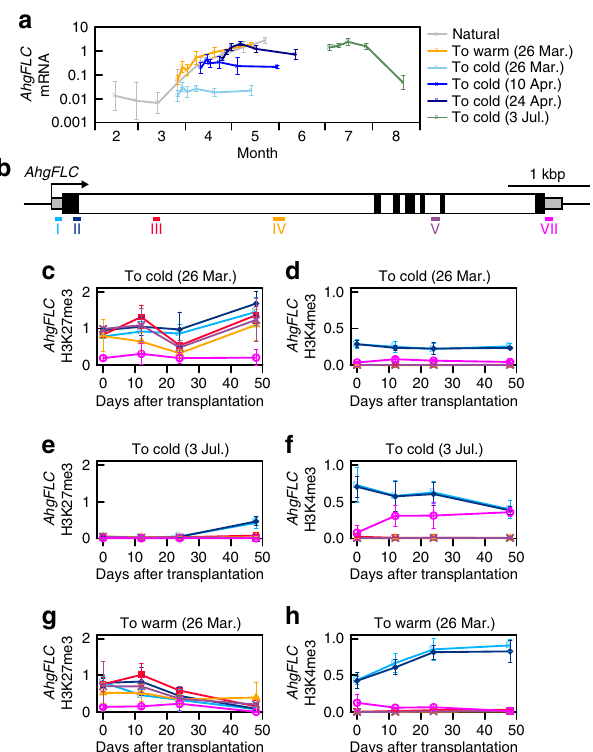
Fig. 6 Lack of AhgFLC cold responses in spring and the role of H3K27me3 at the distal nucleation region. a AhgFLC mRNA levels in naturally growing plants and in plants transferred to warm or cold conditions on the indicated dates. Data are normalised against AhgACT2 . The means and standard deviations of biological replicates are shown. n = 4 for naturally growing plants; n = 3 for transplanted plants. b The distribution of six H3K27me3 and H3K4me3 ChIP amplicons along the AhgFLC locus is shown in different colours. c , d AhgFLC H3K27me3 ( c ) and H3K4me3 ( d ) levels after transfer to cold on 26 March. e , f AhgFLC H3K27me3 ( e ) and H3K4me3 ( f ) levels after transfer to cold on 3 July. g , h AhgFLC H3K27me3 ( g ) and H3K4me3 ( h ) levels after transfer to warm on 26 March. Data are normalised against AhgSTM (H3K27me3) and AhgACT2 (H3K4me3). In c – h , the colour code corresponds to that in b , and the means and standard deviations of biological replicates are shown ( n = 3). For each replicate, a pool of leaves from two plants (out of six plants) was analysed. Source data underlying Fig. 6a, c – h are provided as a Source Data fi